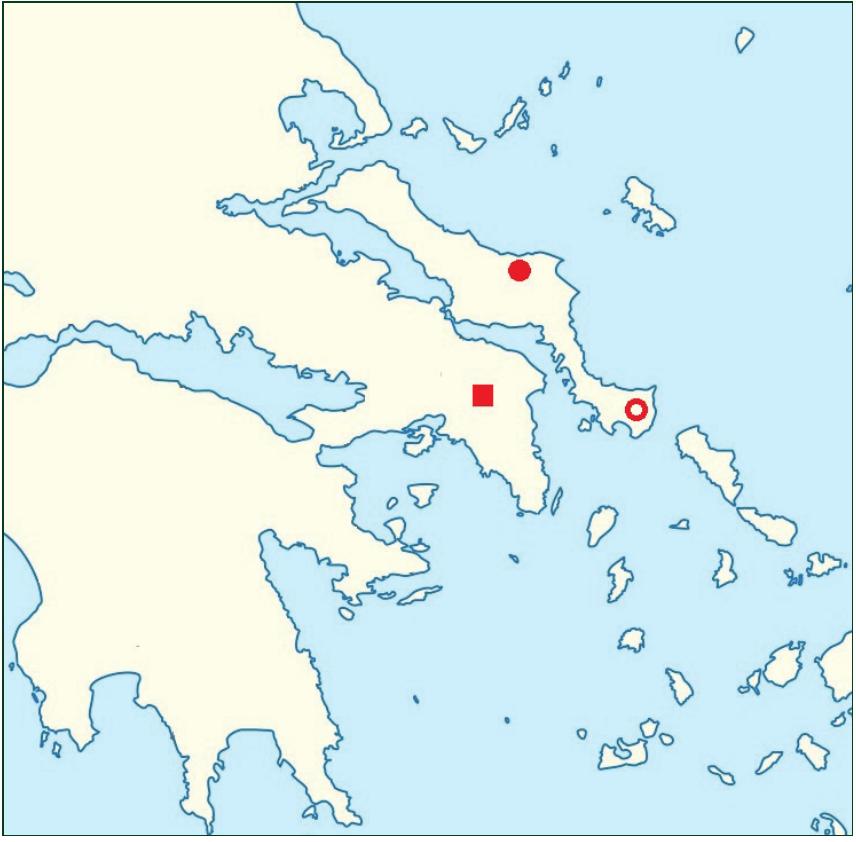
Figure 4. Distribution map of Verbascum delphicum :  subsp. cervi ;  ,  subsp. delphicum ;  var. filictorum